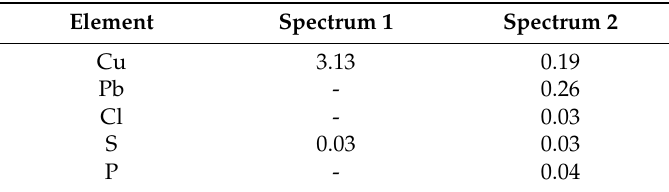
Table 4. Chemical composition of impurities in the pores formed on tube side of SG flakes using SEM-EDS analysis (wt.%).